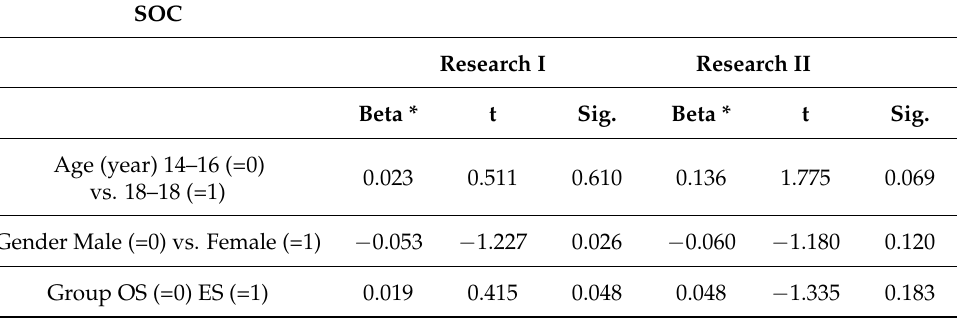
Table 4. Standardized regression coefficients and significance levels of the factors and inde- pendent variables assumed to influence the perception of coherence based on a multiple linear regression model.